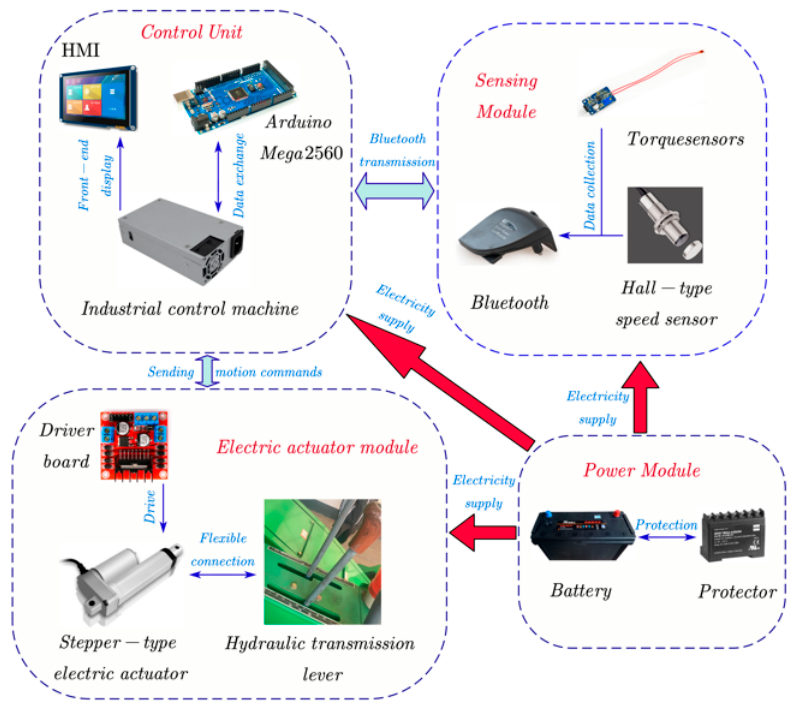
Figure 5. Hardware block diagram of the control system.